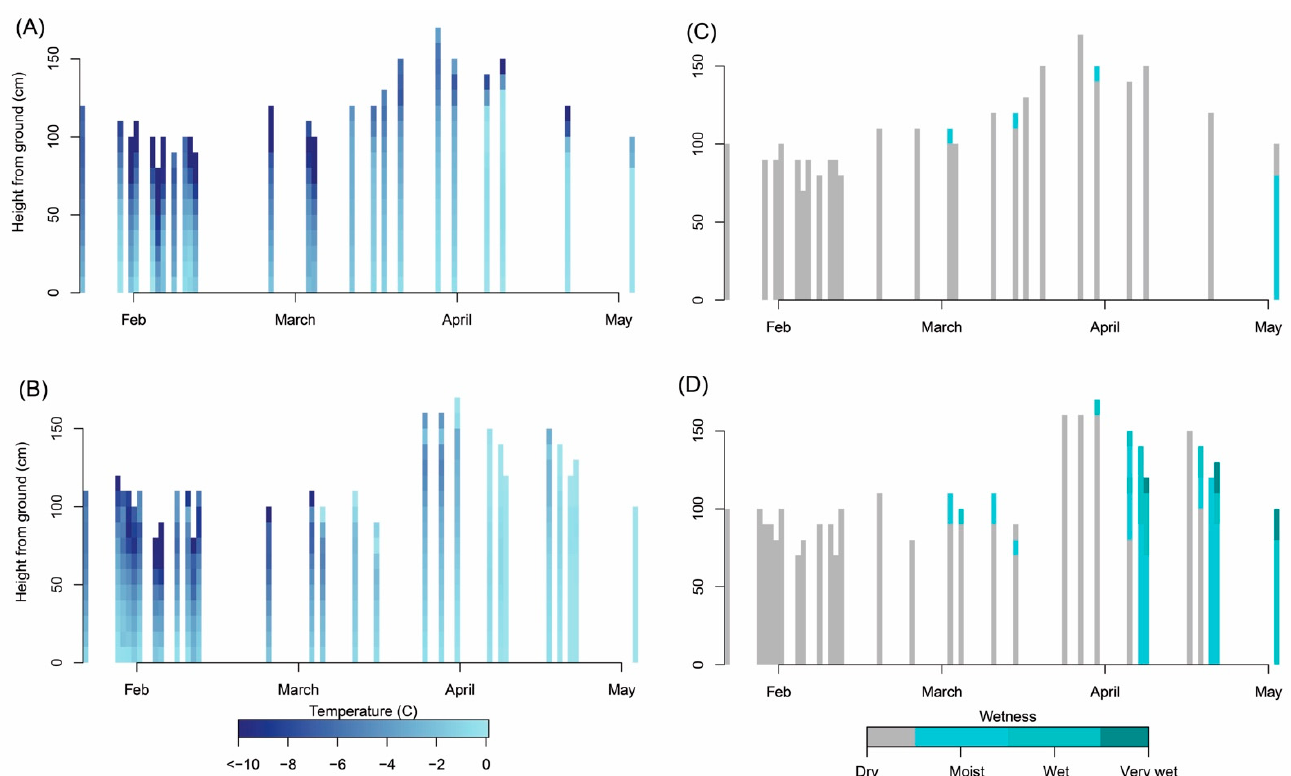
Figure 5. Snowpack temperature and wetness with depth over time, from 22 January–3 May. ( A ) morning temperatures; ( B ) evening temperatures; ( C ) morning wetness; ( D ) evening wetness.